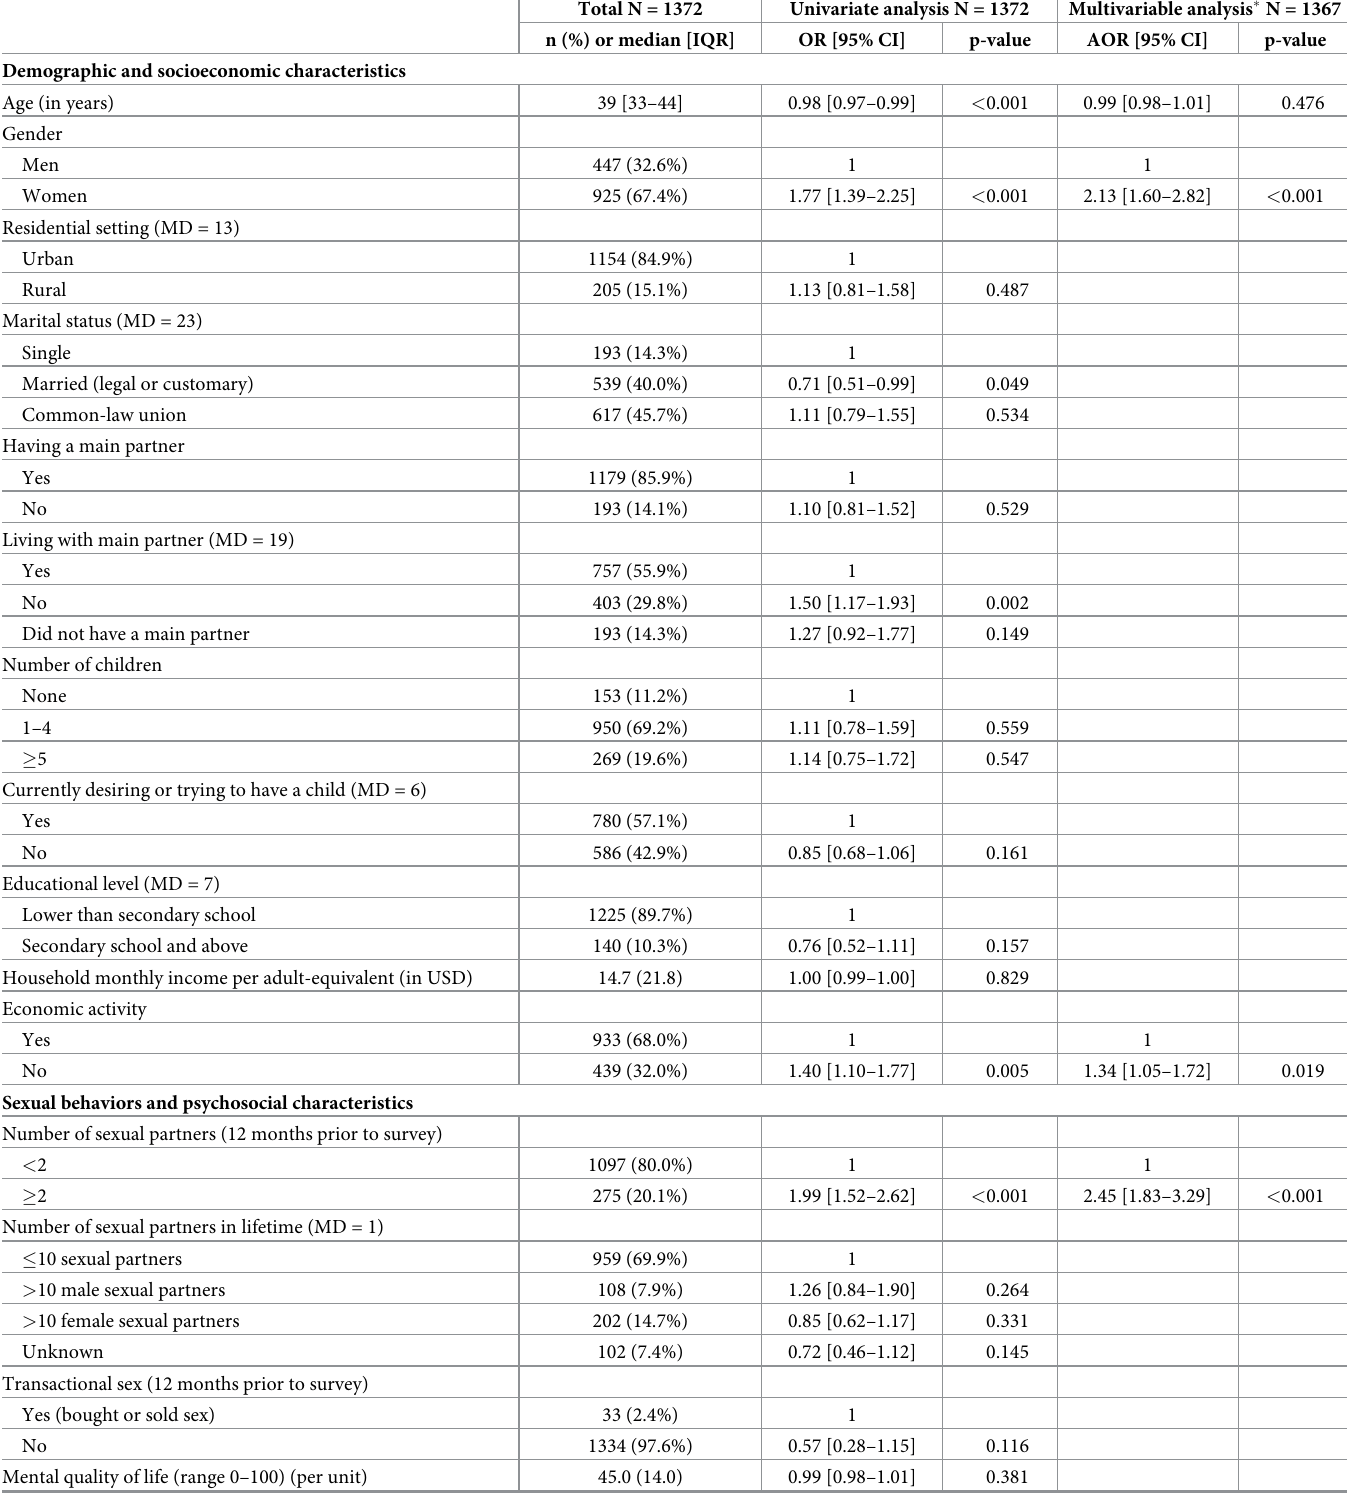
Table 1. Individual and healthcare supply-related factors associated with HIV transmission risk (EVOLCam survey, ANRS